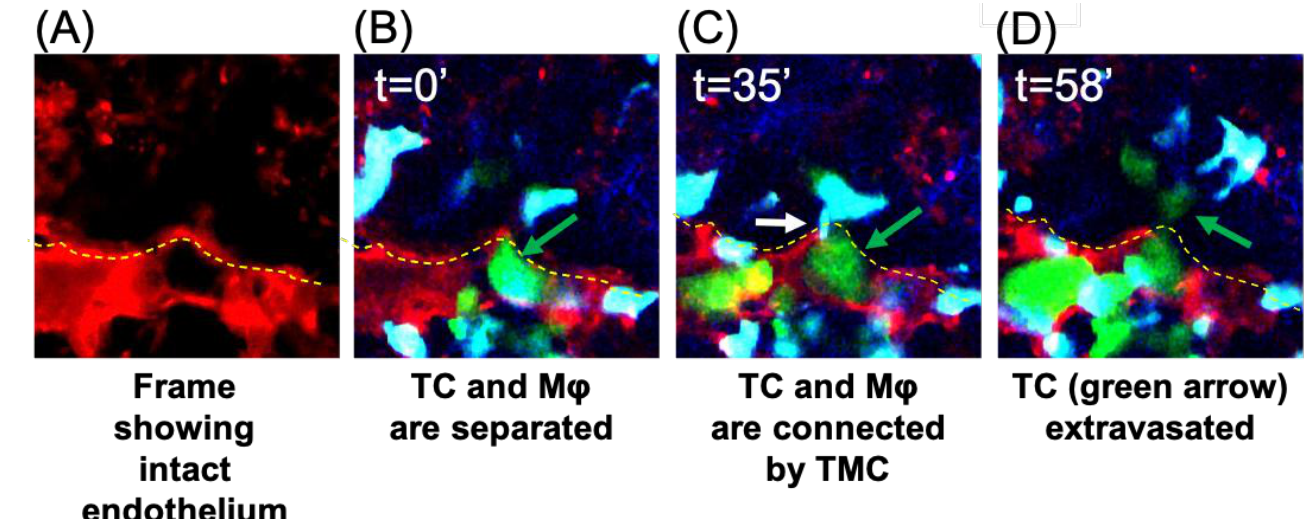
Figure 5. IVI of tumor cell extravasation to the lung reveals the presence of a thin membranous connection (TMC) from a tissue macrophage contacting a circulating tumor cell prior to tumor cell extravasation. Tumor cells were injected through the tail vein in mice bearing a WHRIL (window for high-resolution imaging of the lung) which was surgically implanted over the lungs of mice expressing ECFP in macrophages and td-tomato labeled vasculature. Within a few minutes post injection of tumor cells, images were collected over time. ( A ) Representative image showing the intact endothelium (red) of the lung capillary. ( B ) Representative image of a stationary E0771-GFP tumor cell (green) in a lung capillary at the point at which it is arrested in the vasculature (t = 0 ′ ). This tumor cell was followed throughout the extravasation process and is indicated by the green arrow in each panel. ( C ) A TMC (white arrow) protruding from the macrophage and connecting to the stationary intravascular tumor cell in panel B indicated by the green arrow (t = 35 ′ ). ( D ) Tumor cell indicated in panels B and C has extravasated into the lung parenchyma (green arrow). In all images, a yellow dashed line indicates the intact blood vessel endothelium (red) of the lung capillary (seen in ( A )) separating circulating tumor cells (green) and macrophages (blue) that reside the pa- renchyma. 4. Discussion Metastasis is estimated to be responsible for approximately two thirds of cancer-re- lated mortality [44]. The importance of macrophages in promoting metastatic dissemina- tion and growth in primary as well as secondary breast cancers is well known [3,5,6]. In this work, we focused our attention on the role of macrophages in tumor cell extravasation and, in particular, on the physical interaction between macrophages and tumor cells that reside on opposing sides of the lung vasculature. We were able to identify TMCs in an in vitro assay that mimics the extravasation process. Similar barrier-crossing membranous extensions have already been described to be made by different immune cells in vivo . Dendritic cells send dendrites outside the epithelium to sample bacteria in the intestinal lumen [45] and hematopoietic stem cells send TMCs across the dense basement mem- branes to deliver lysosomes into diseased proximal tubular cells when grafted to cysti- notic kidneys [46]. However, we are the first to show a connection between tumor cells and macrophages in the context of the metastases both in vitro and their importance in tumor cell extravasation in vivo.